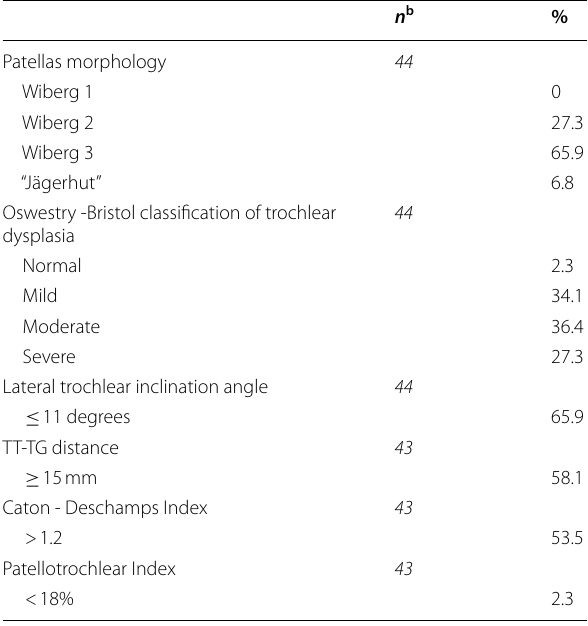
Table 4 Patellofemoral anatomical features on radiographs